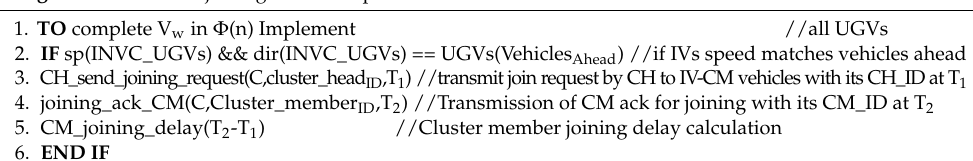
Algorithm 8. Cluster joining function upon new CM